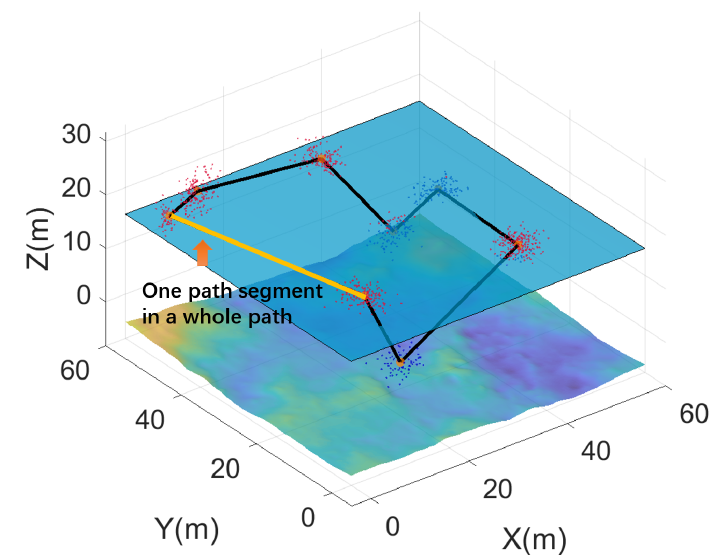
Figure 1. The path segment will be weighted according to the environment. Along each path segment Γ i , the HAUV should move with the corresponding maxi- mum velocity and acceleration. Additionally, the final output trajectory F x , y , z free from obstacle spots, which contain the unknown obstacles OBS and terrain barriers TE